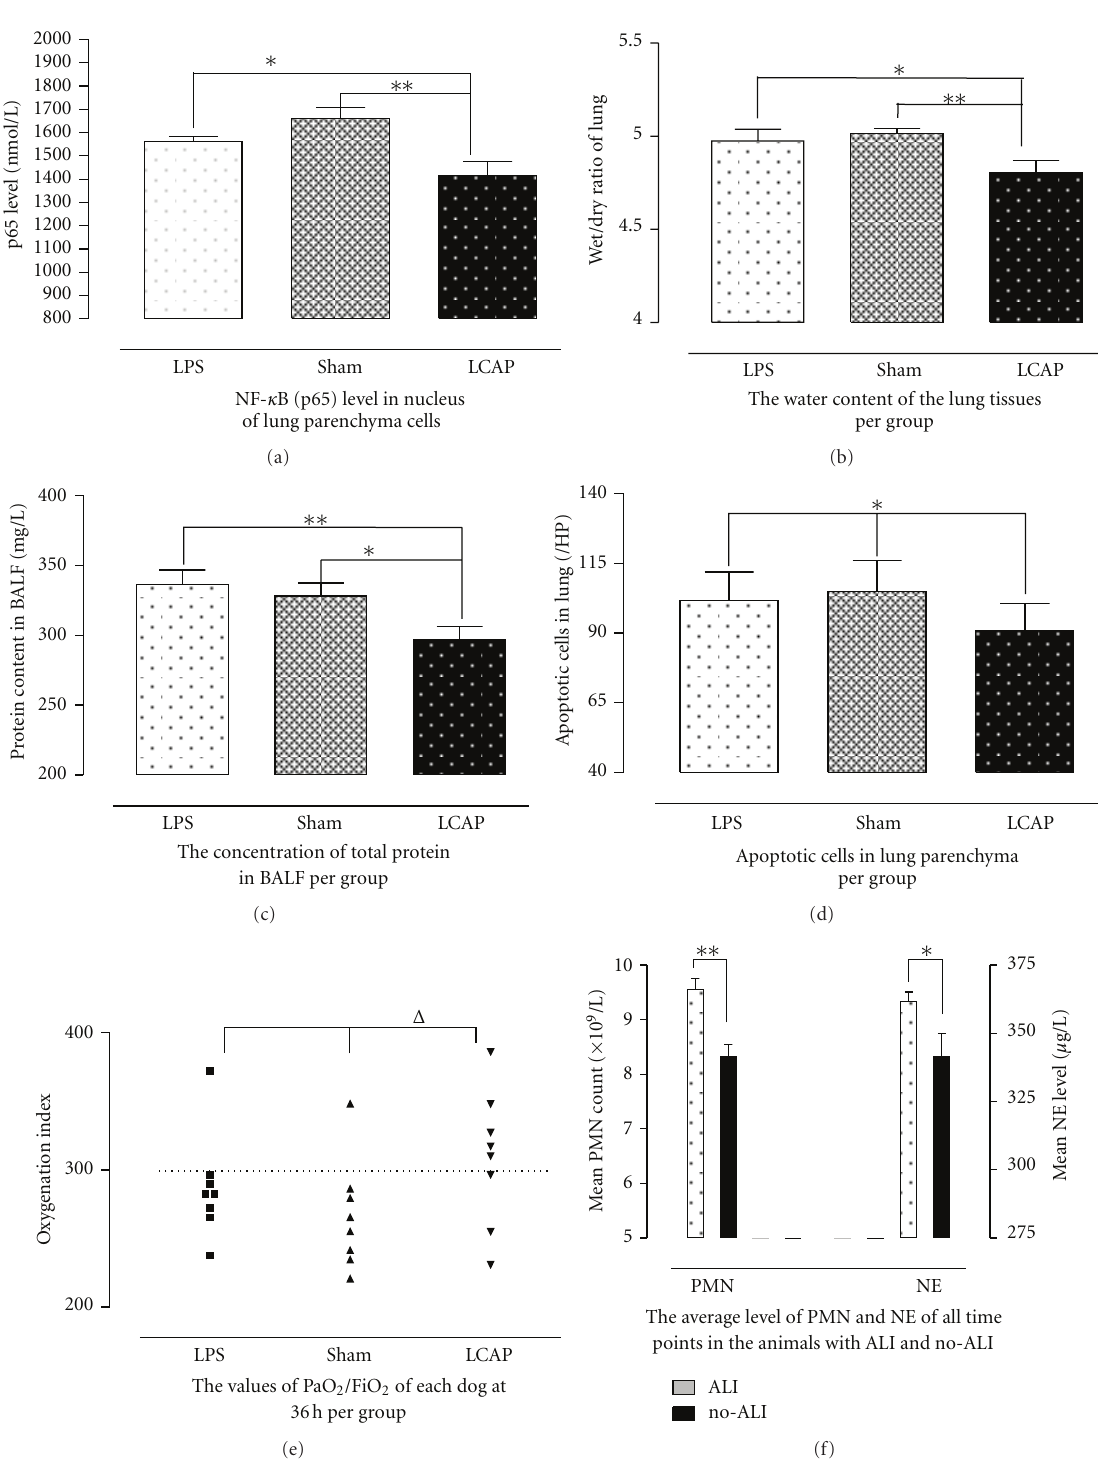
Figure 4: The e ff ect of LCAP on p65 protein levels in lung parenchyma, total protein concentration in BALF, wet/dry ratio in lung, and apoptotic changes in lung tissues. The p65 was examined by ELISA kits, and optical density was read at 450nm (a). The water content of the tissues from left inferior lung was shown as wet/dry weight ratio (b). The total protein concentration in BALF assayed by methods of Bradford (c); apoptotic cells (arrow) in left inferior lung parenchyma were detected by TUNEL in situ assay using an In Situ Cell Death Detection Kit (d); incidence rate of ALI/ARDS was diagnosed according to the criteria for ALI/ARDS by the American-European Consensus Conference of 1994 (e). The mean levels of PMN counts and NE in the 7 animals without ALI were compared to 17 animals with ALI (f). ∗ indicates significant di ff erence among the LCAP, LPS, and the sham-LCAP groups ( ∗ P < 0 . 05; ∗∗ P < 0 . 01); Δ indicates significant di ff erence among the LCAP, LPS, and sham-LCAP groups ( P < 0 .